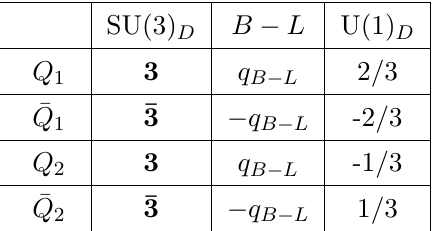
Table 2 . The charge assignment of the minimal model for N c = 3 and N f = 2. The QED 0 charges are assigned so that one of the dark baryon becomes